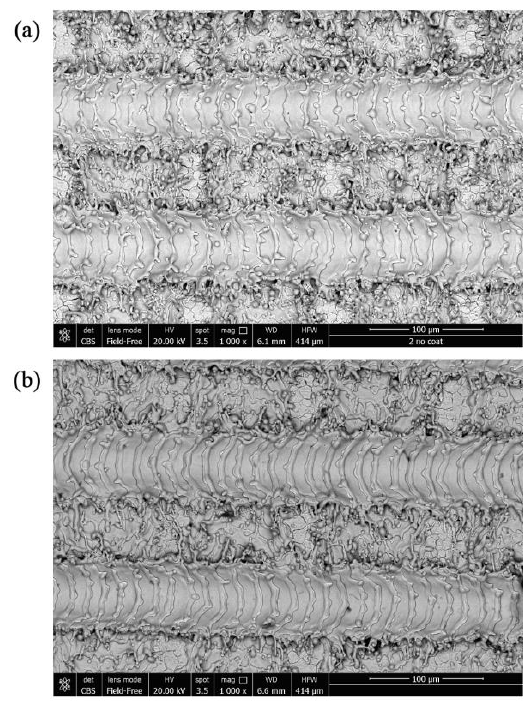
Figure 12. SEM images of surfaces obtained with parallel lines scanning strategy at 7 W: ( a ) laser texturing only; ( b ) Surf 1 sample (laser texturing + sol – gel (TEOS)).